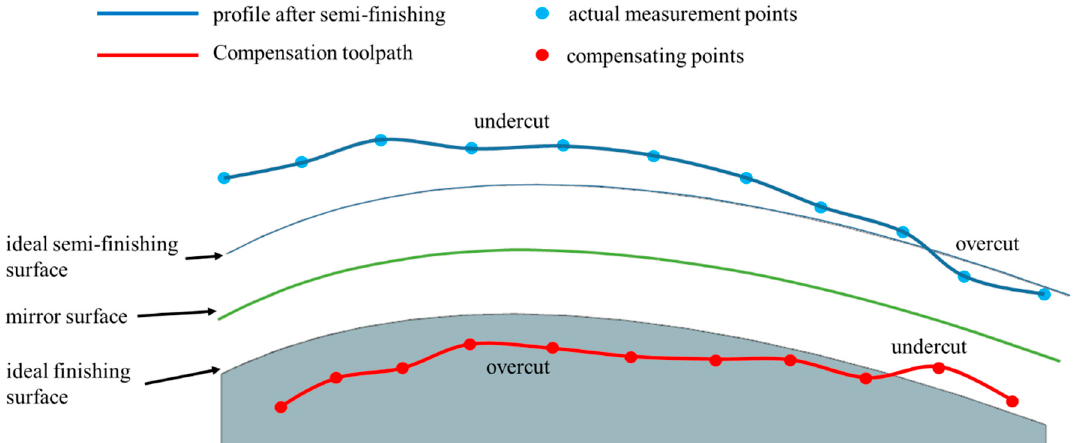
Figure 6. Illustration of the mirror compensation